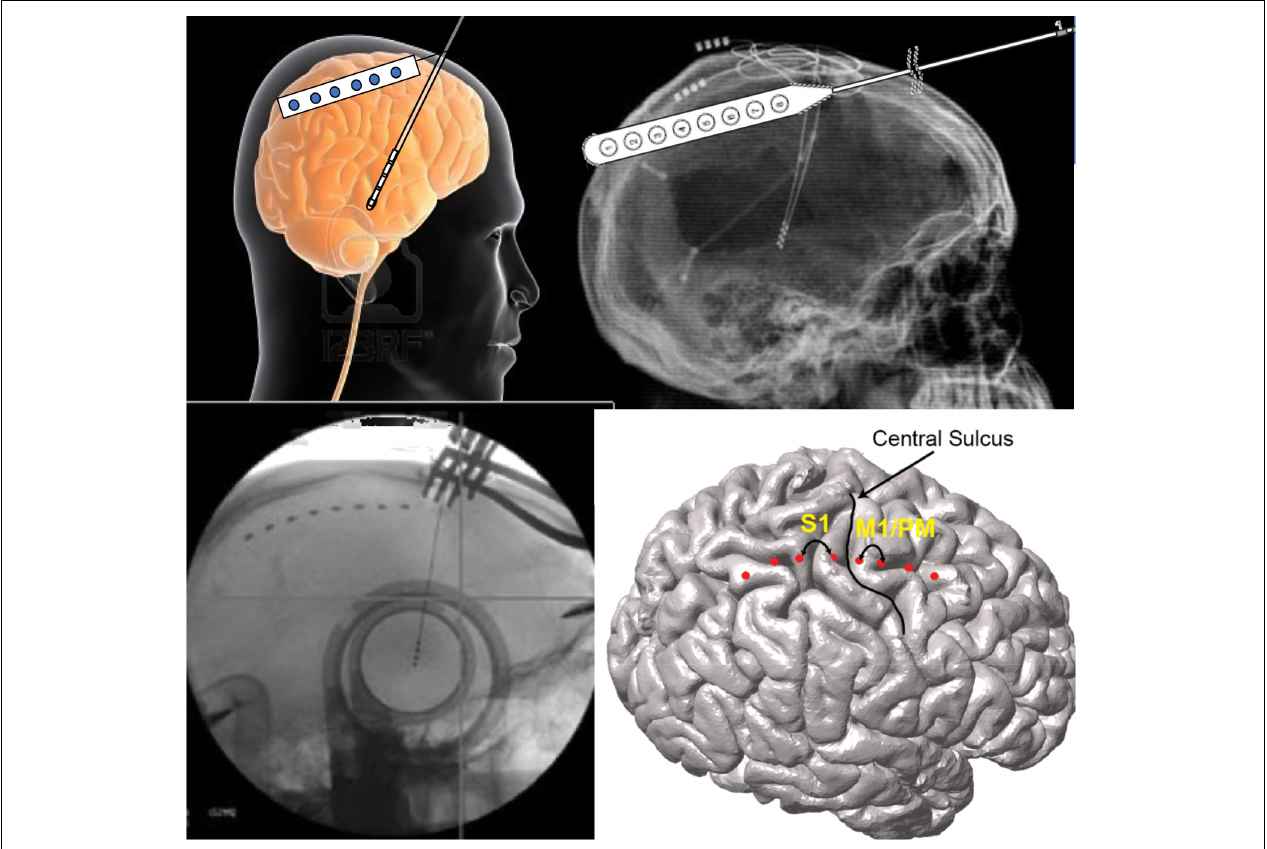
FIGURE 2 | Network-based measures can be recorded during DBS surgery via the same burr hole utilized for DBS lead implantation. In these illustrations, the use of an electrocorticography strip is shown. Simultaneous signals are recorded from the motor cortices while also recording through the DBS